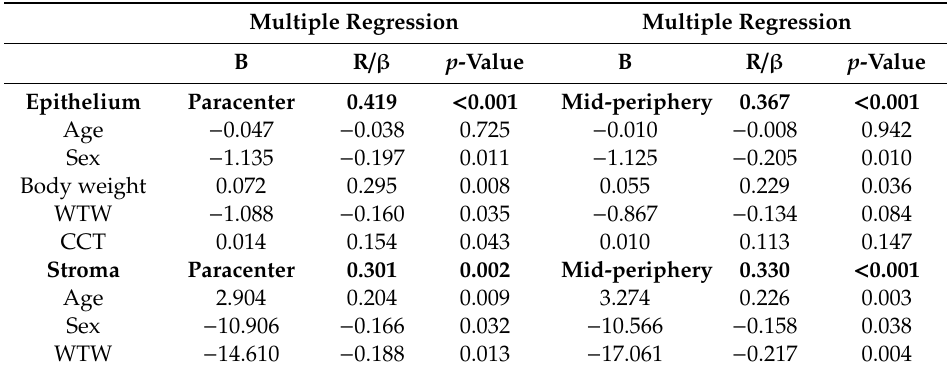
Table 4. Factors a ff ecting corneal epithelial and stromal thickness in the paracenter and mid-periphery in Korean school children ( n = 165).